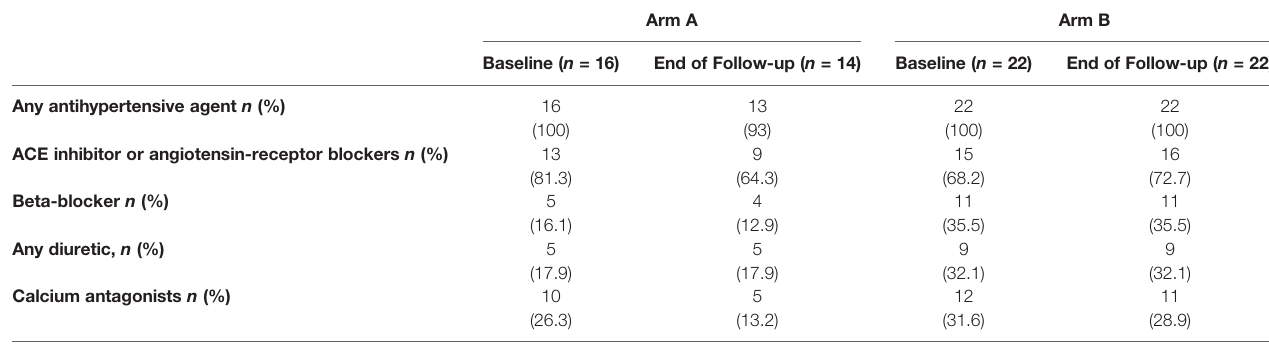
TABLE 1 | Number of patients taking a speci fi c class of antihypertensive treatment.